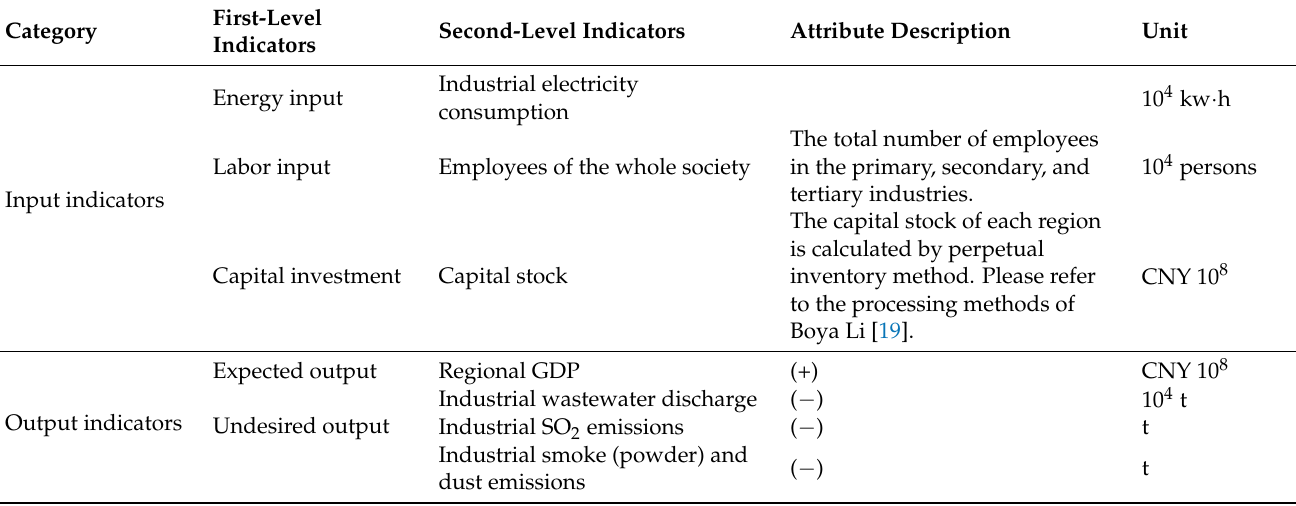
Table 1. Green economy efficiency input–output index